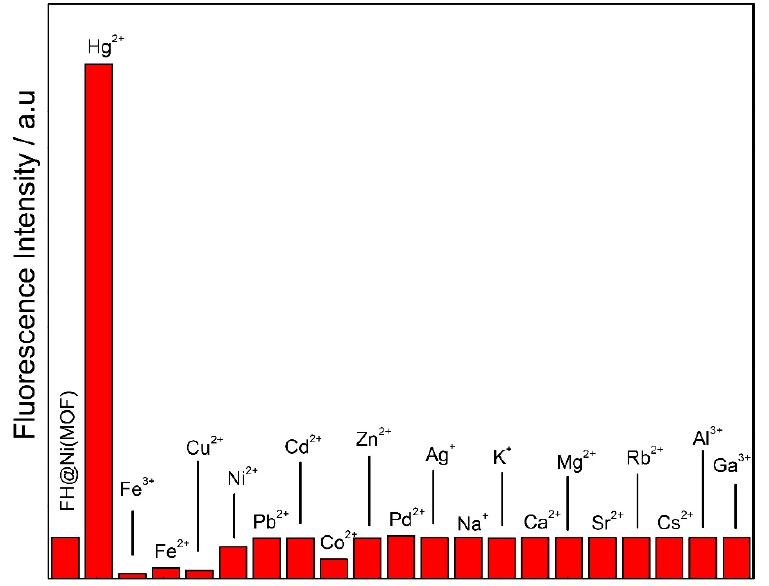
Figure 6. Change in the fluorescence intensity of FH@Ni(MOF) in water upon the addition of 200 µ L of different metal cations (10 − 2 M).